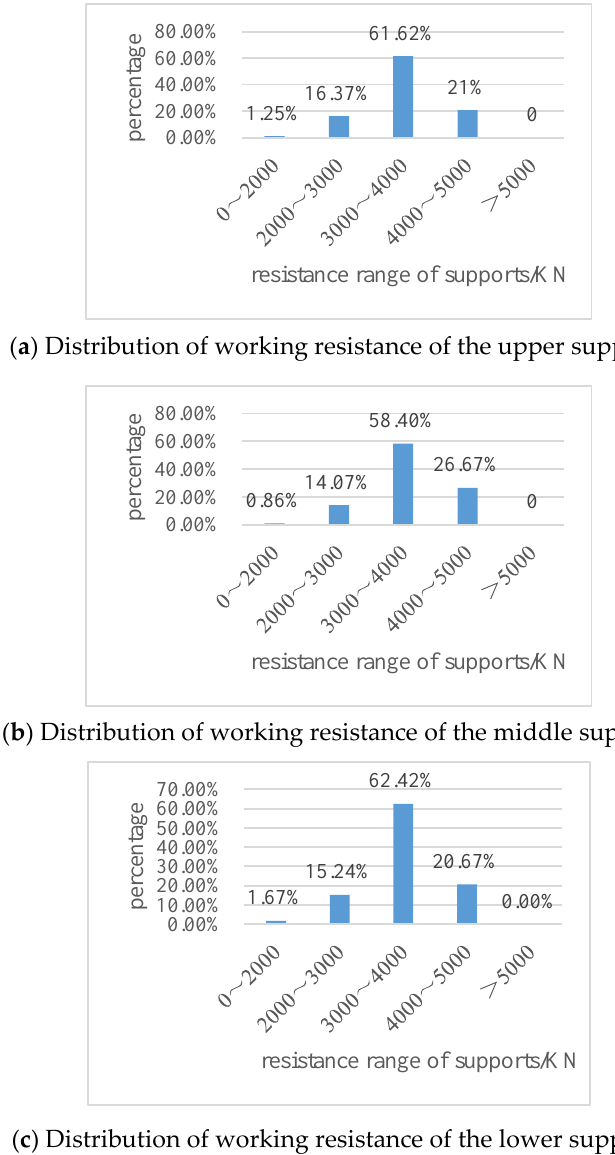
Figure 11. Distribution of working resistance of the 051508 working face supports.